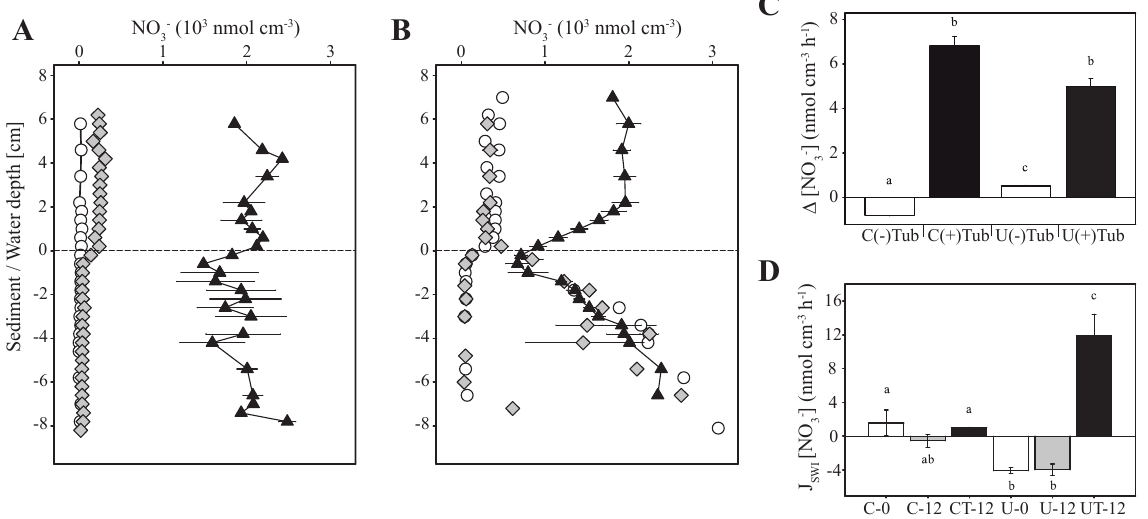
Figure 5. Dissolved nitrate concentration profiles in uncontaminated ( A ) and U-spiked sediment ( B ) in the different treatments: at initial conditions [C-0] and [U-0] ( (cid:13) ), and after 12 days without [U-12] ( ♦ ) or with [UT-12] ( N ) T. tubifex worms in the sediment. The bar chart ( C ) corresponds to the net accumulation rates in the water column after 12 days. The bar chart ( D ) indicates the integrated diffusive fluxes at the sediment–water interface estimated using PROFILE software. Means ± SD ( N = 3). Different letters correspond to significant differences between treatments.